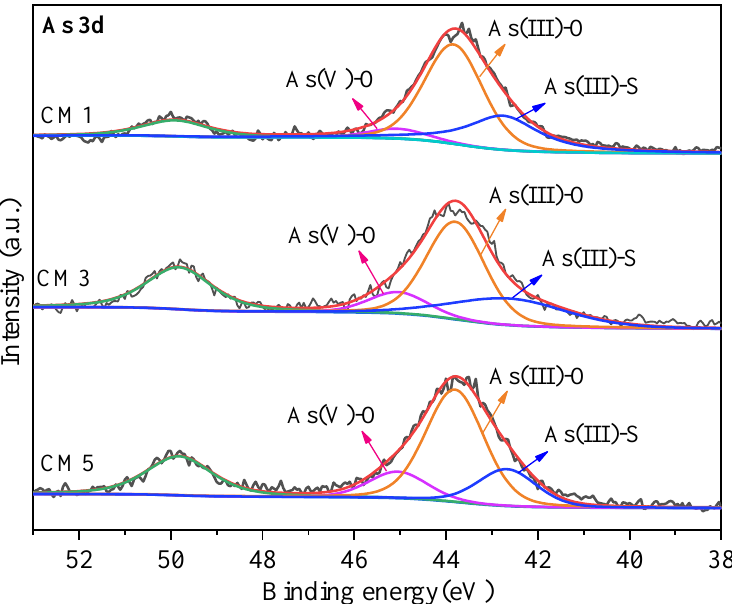
Figure 5. XPS spectra of CM1, CM3, and CM5 ( As 3d ).